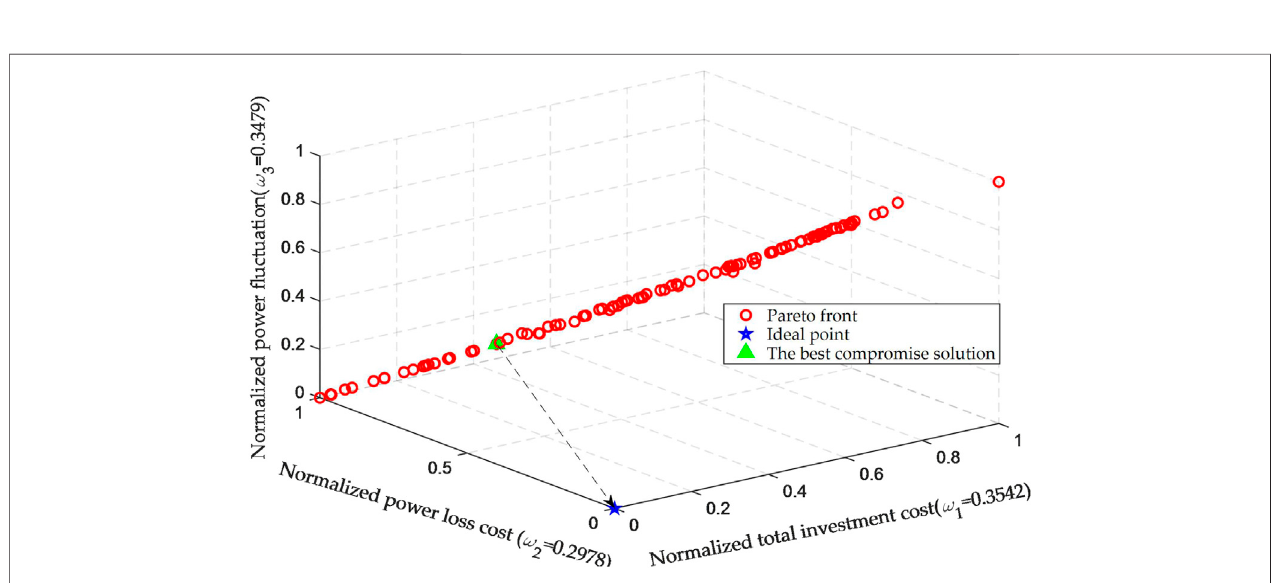
FIGURE 8 | Three-objective Pareto front results obtained by two algorithms: (A) MOPSO; (B) MMSSA.